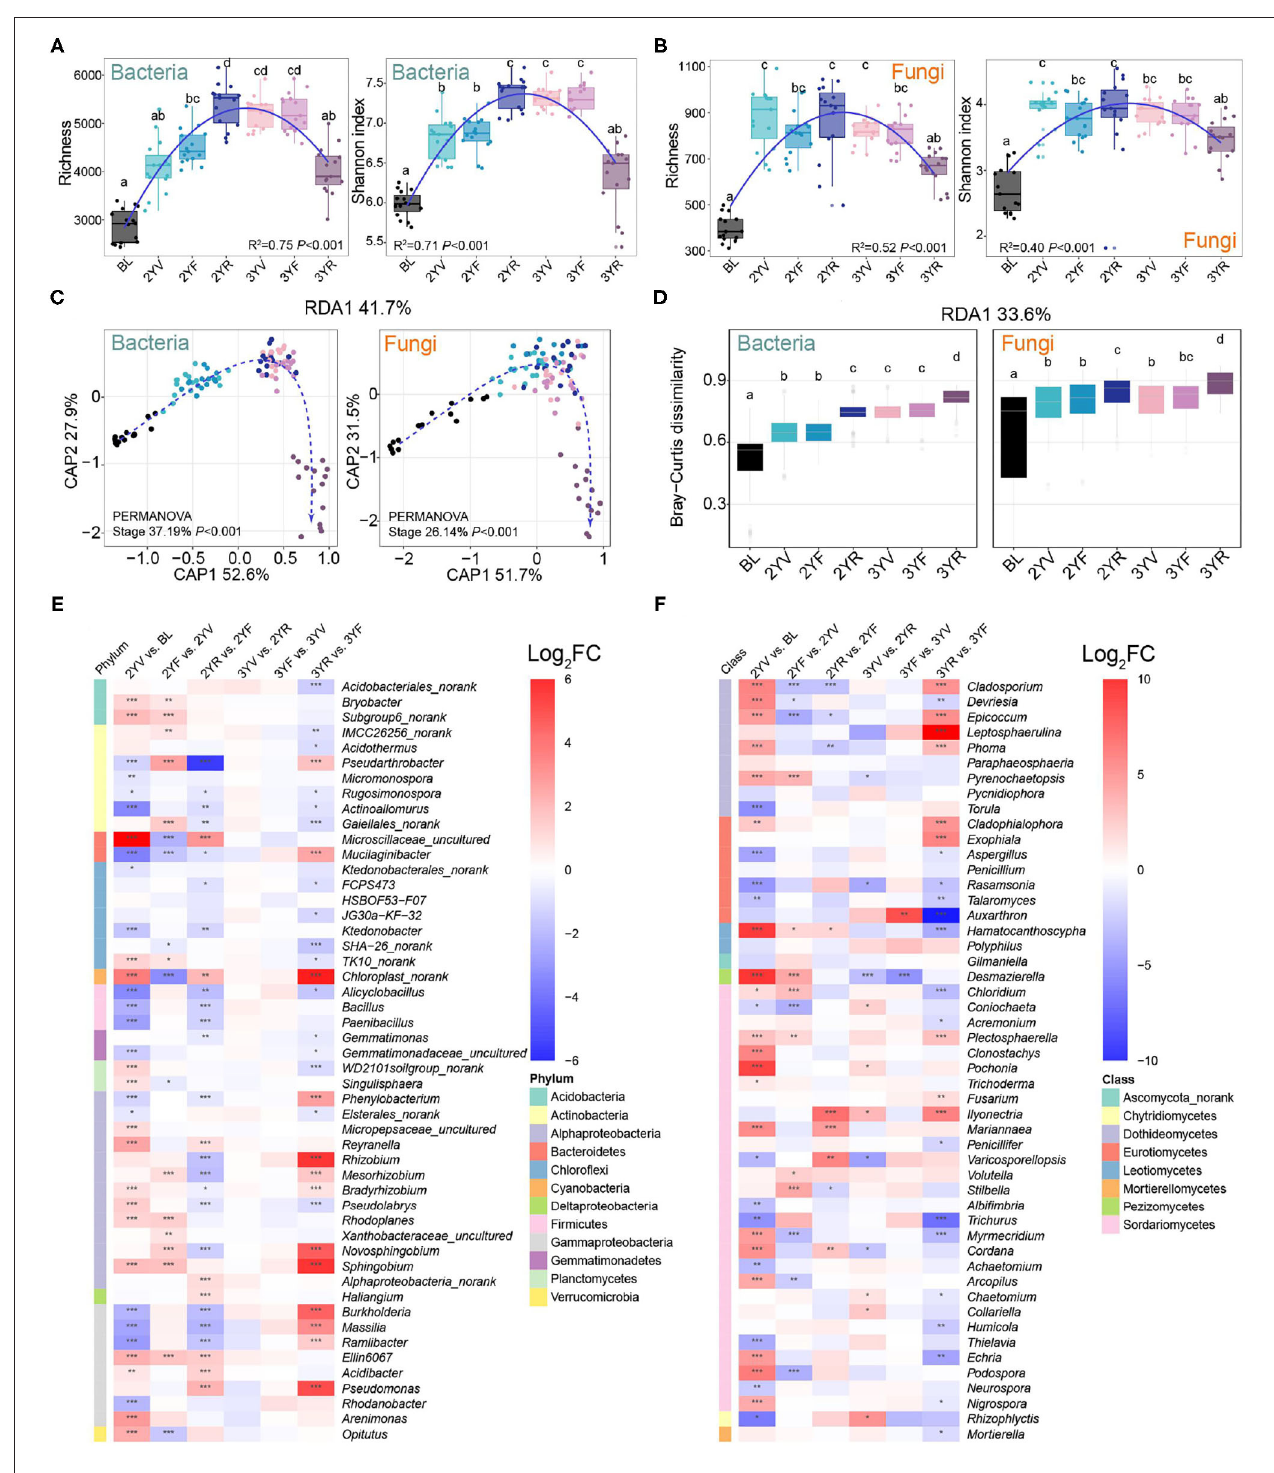
FIGURE 2 | Changes in α - and β -diversities of bacterial and fungal communities across developmental stages of P. notoginseng . Bacterial (A) and fungal (B) α -diversities at different growth stages are represented by operational taxonomic unit (OTU) richness and Shannon index. BL, 2YV, 2YF, 2YR, 3YV, 3YF, and 3YR represent BLs and the 2-year vegetative, 2-year flowering, 2-year root growth, 3-year vegetative, 3-year flowering, and 3-year root growth stages, respectively. (C) Variation of bacterial and fungal communities constrained to developmental stages based on principal coordinates analysis (CAP). (D) Bray–Curtis distances between BLs and rhizosphere soils of other stages. The enrichment and depletion of bacterial (E) and fungal (F) genera with the average relative abundance of the top 50. Color represents log-transformed fold change. Different letters denote significance between compared groups ( P < 0.05). * P < 0.05 ; ** P < 0.01 ; *** P < 0.001.